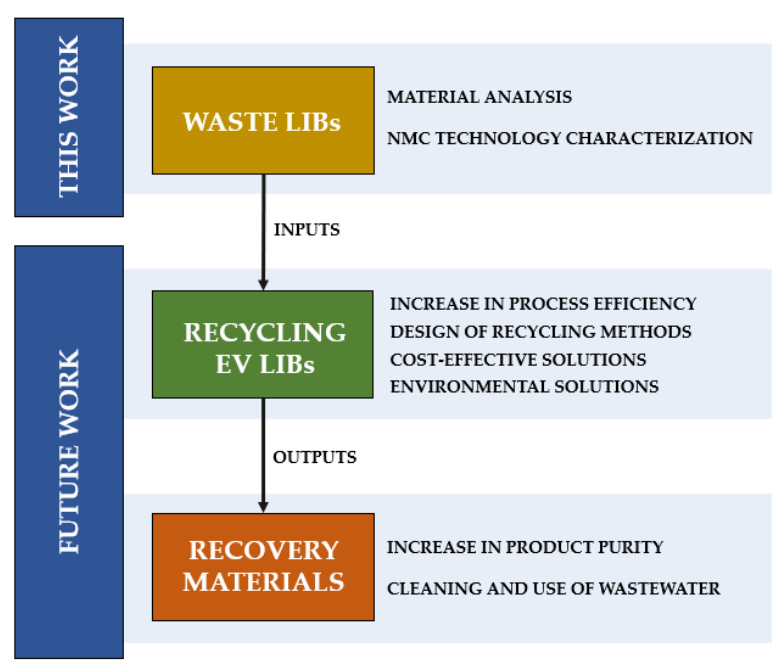
Figure 11. Inclusion of this work in the context of LIBs recycling and follow-up work.